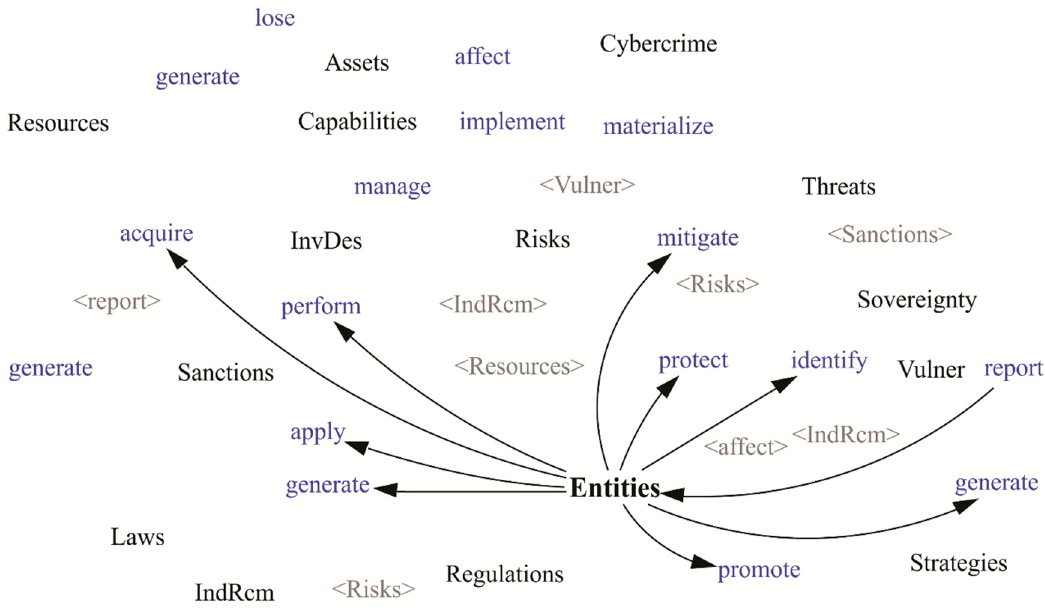
Figure 9. Actions carried out by the entities.